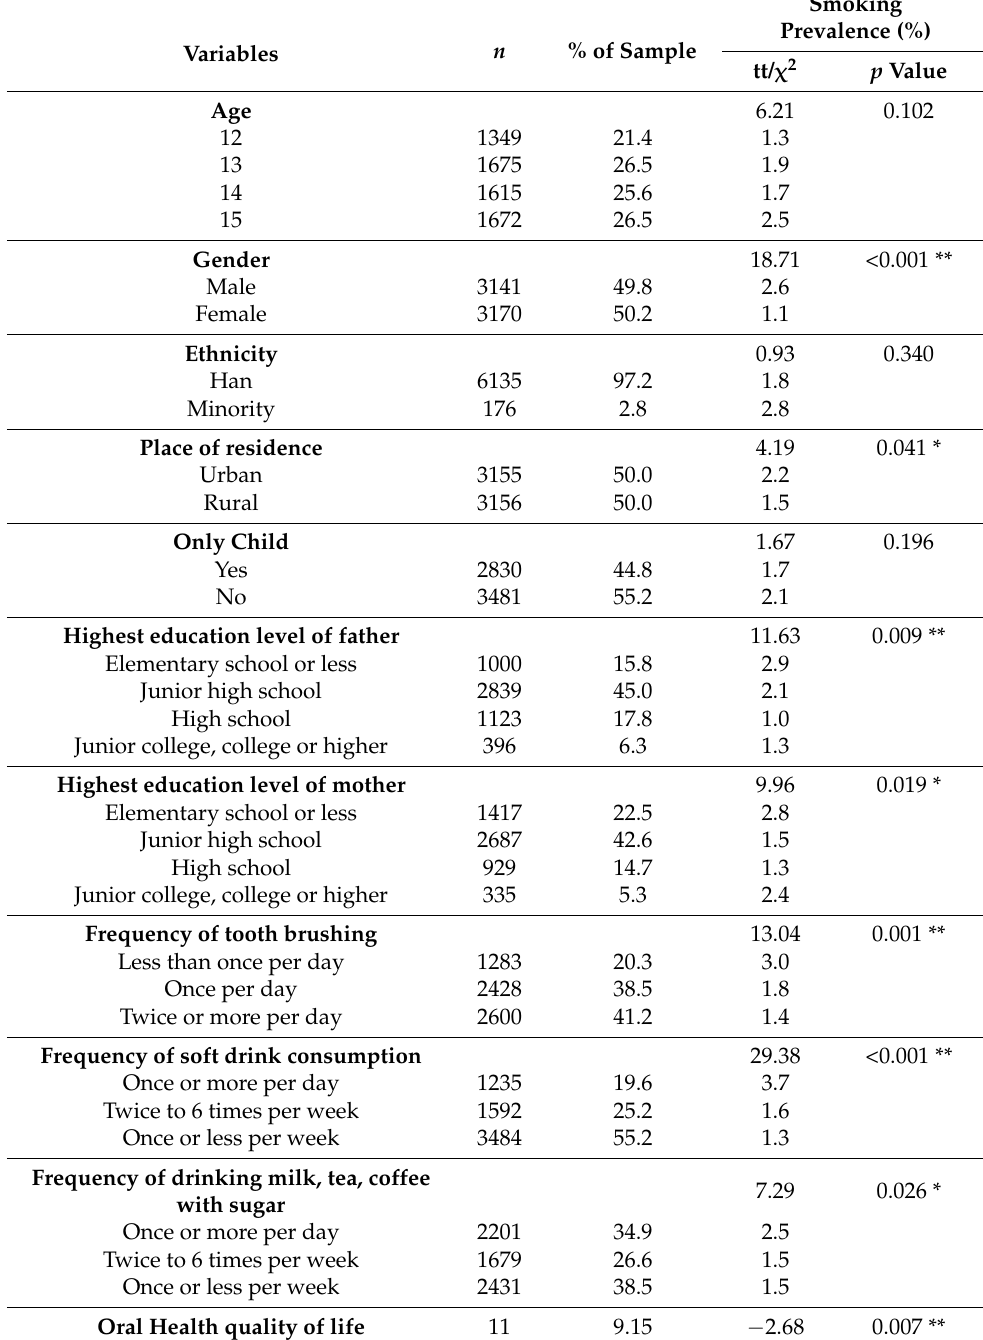
Table 2. Smoking prevalence by demographics characteristics, tooth